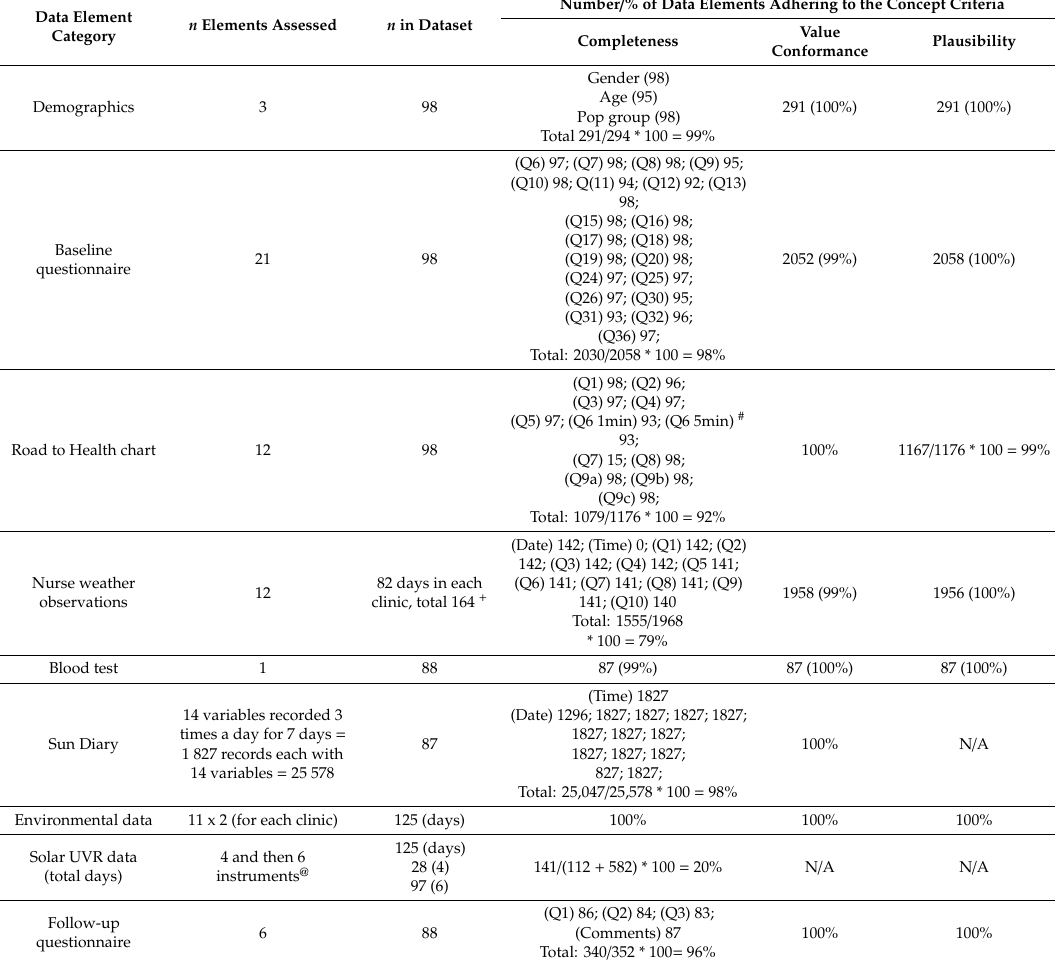
Table 1. Tool assessment framework adapted from Lee et al. [15] with total data elements by category and number of data elements adhering to the concept